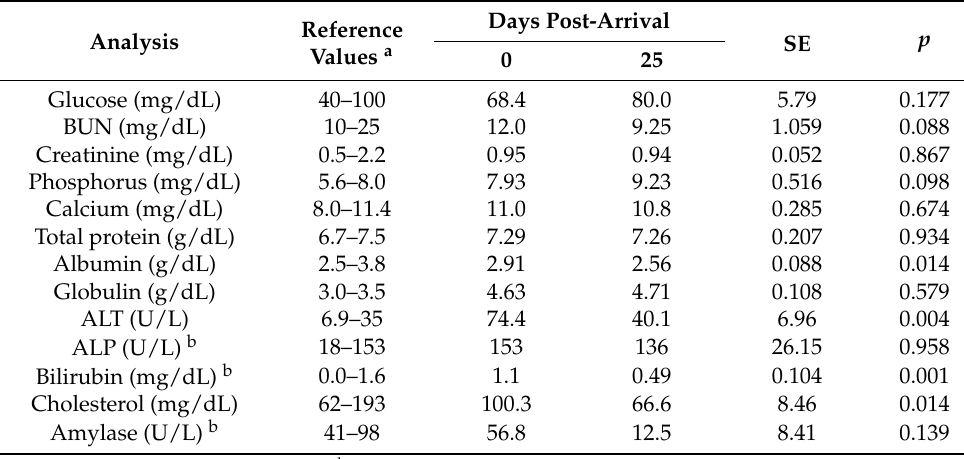
Table 4. Blood chemistry values of heifers at 0 and 25 days post-arrival.